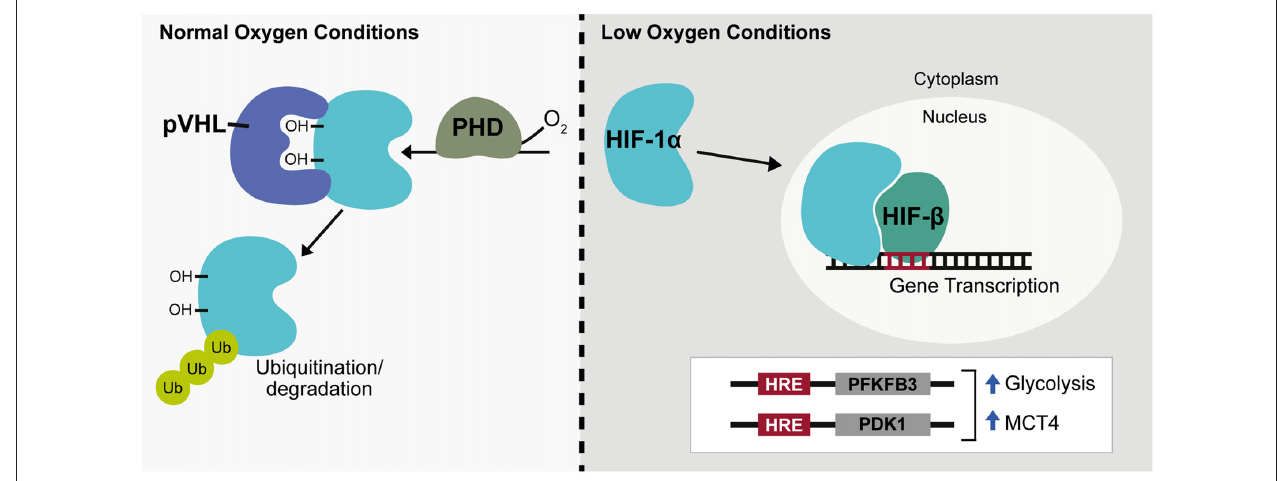
FIGURE 2 | Hypoxia inducible transcription factor regulation. Under normal oxygen conditions hypoxia-inducible factor-1 α (HIF-1 α ) is hydroxylated by prolyl hydroxylase (PHD) enzymes and targeted for ubiquitination by the Von Hippel-Lindau tumor suppresser ubiquitin ligase complex (pVHL). During hypoxia or low oxygen conditions, HIF-1 α is stabilized, translocates to the nucleus and associates with HIF- β to promote gene expression, targeting genes containing a hypoxia response element (HRE). HIF-1 α acts as a glycolytic enhancer through transcriptional activation of metabolic genes including 6-phosphofructo-2-kinase/fructose-2,6-bisphosphate 3 (PFKFB3) and pyruvate dehydrogenase kinase-1 (PDK1), both positive regulators of glycolysis and monocarboxylate transporter 4 (MCT4), the lactate efflux transporter. Ub, ubiquitin; OH, hydroxyl